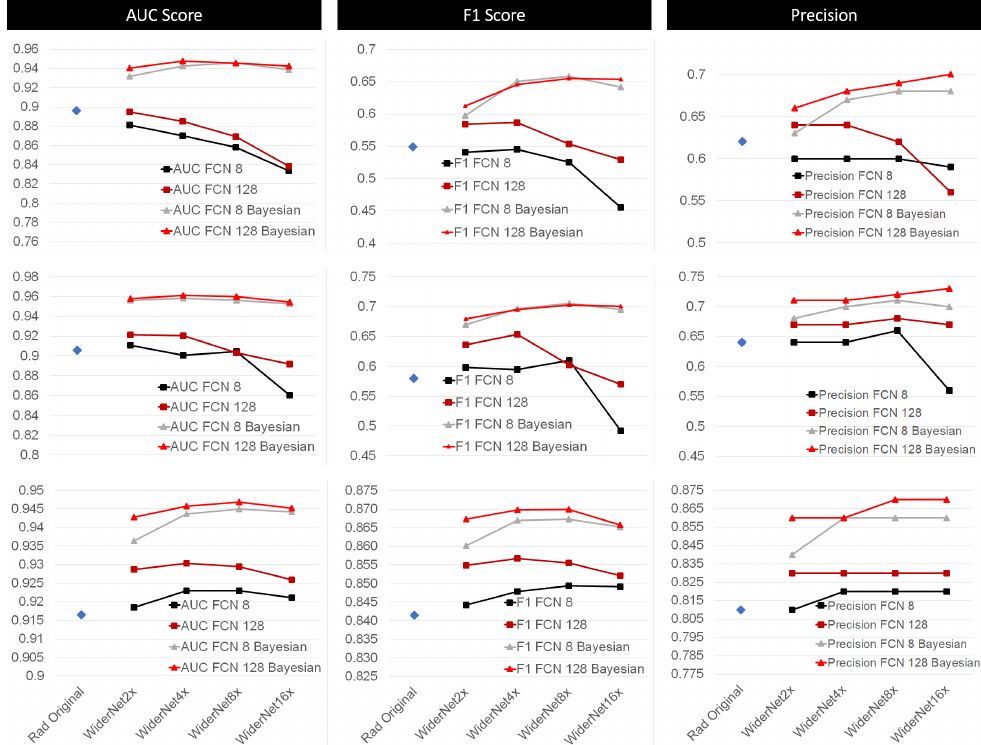
Figure 3. Performance of the presented architectures on the datasets. ( Top ) EDAQA dataset, study 1. ( Middle ) EDAQA dataset, study 2. ( Bottom ) ESDB dataset. The architectures are evaluated under different metrics to aid the elicitation of Bayesian approach on a regular CNN. The columns represent the averages of AUC ( left ), F1-score ( middle ) and precision ( right ), across all subjects and 10 runs. Rad Original is the baseline represented by a blue dot, while the legends identifies the WiderNet variants. We observe an improvement in all models when considering their Bayesian variant. This improvement is more noticeable in the ESDB dataset. Best in